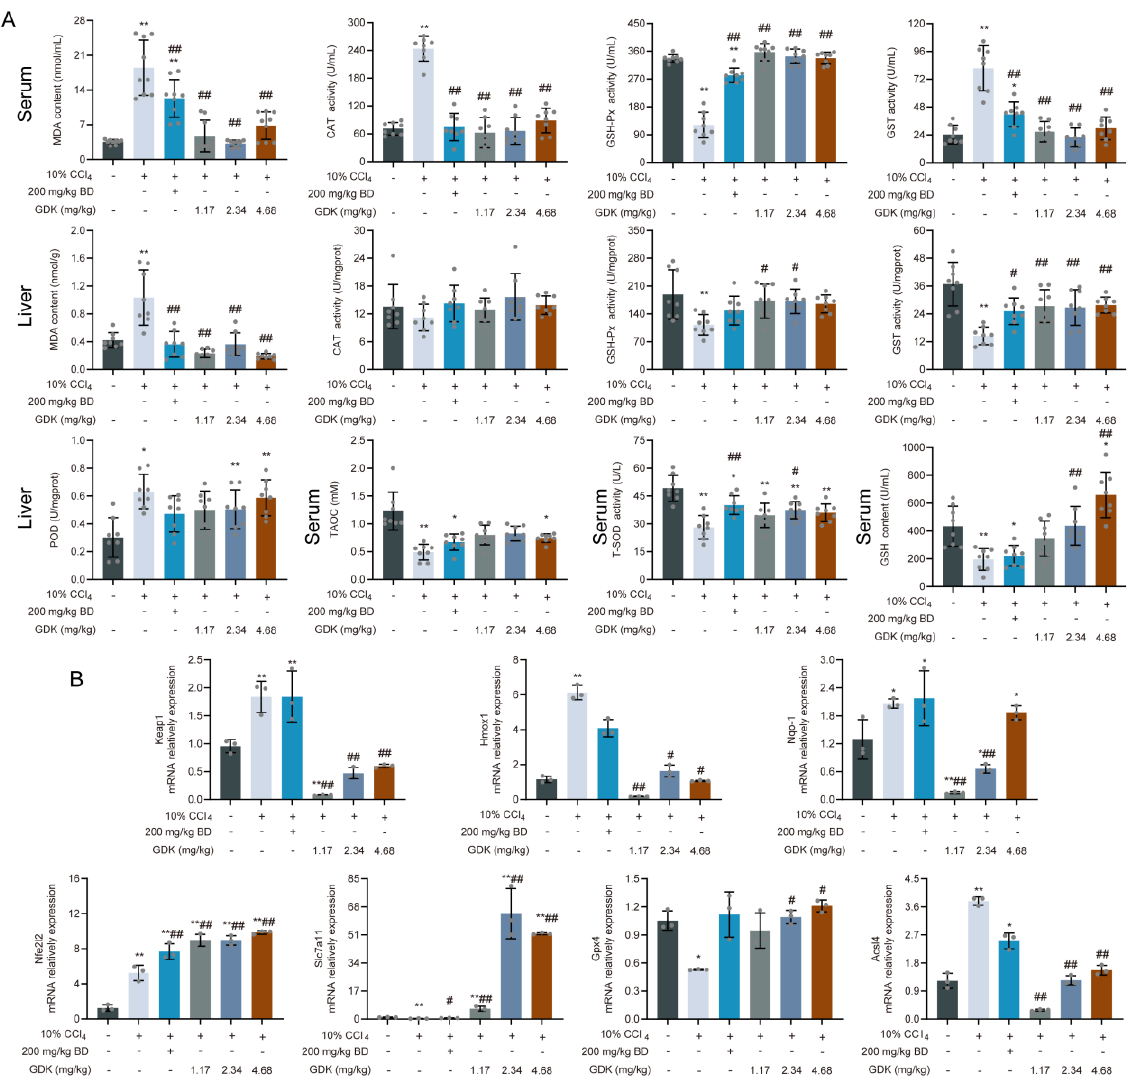
Figure 5. GDK attenuates ferroptosis through the antioxidant system in CCl 4 -induced chronic liver injury mice. ( A ) Levels of serum and liver antioxidants in indicated mice (n = 8 samples per group). ( B ) Relative mRNA levels of Keap-1 , Hmox-1 , Nqo-1 , Nfe2l2 , Slc7a11 , Gpx4 , and Acsl4 . * p < 0.05, ** p < 0.01, # p < 0.05, and ## p < 0.01. n = 3 per group.